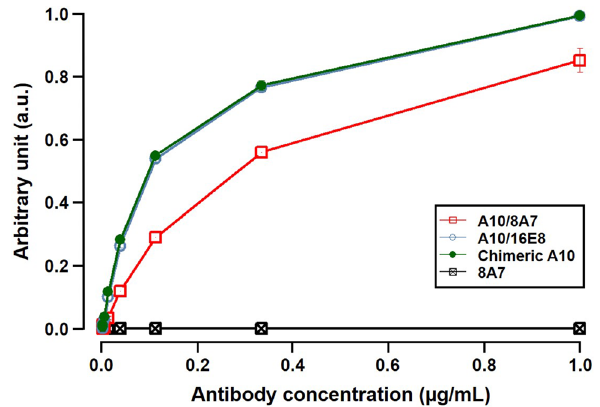
Figure 3. The dose–response relationship of A10/8A7 and A10/16E8 to ADAMTS13 in ELISA tests. Each plot in the dose–response curves was obtained in triplicate. Chimeric A10 and 8A7 were used as positive and negative controls, respectively. The horizontal axis is the concentration of antibodies used in the ELISA test. The vertical axis is standardized absorbance values (arbitrary unit) relative to the values of chimeric A10.